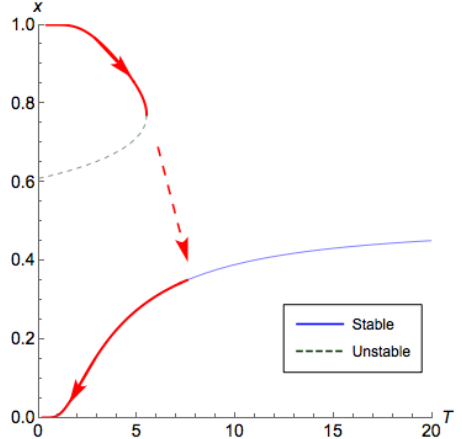
Figure 1. Bifurcation diagram for a 2 × 2 population coordination game. The x axis corresponds to the system temperature T , whereas the y axis corresponds to the projection of the proportion of the first population using the first strategy at equilibrium. For small T , the system exhibits multiple equilibria. Starting at T = 0, and by increasing the temperature beyond the critical threshold T C = 6, and